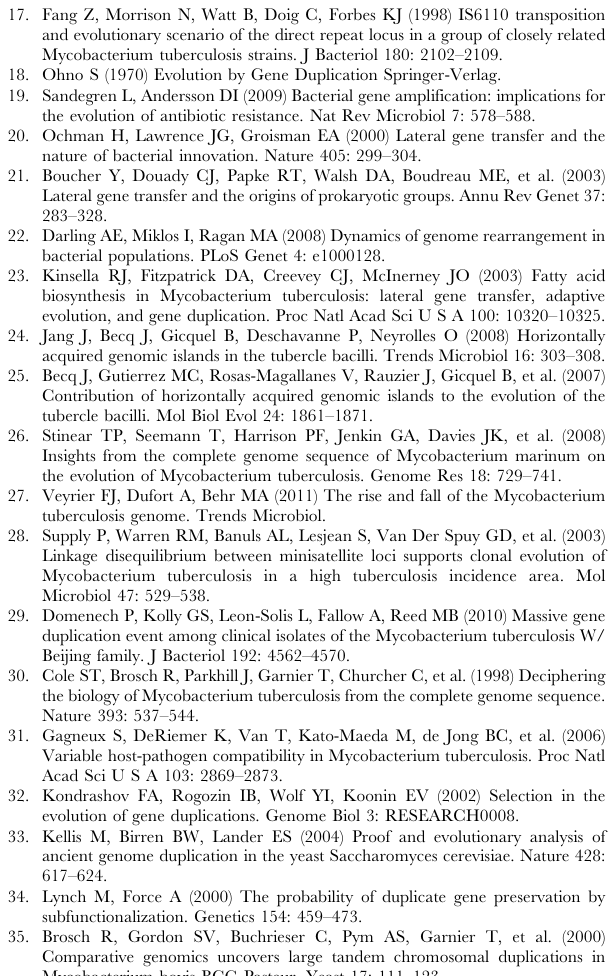
Figure S3 Coverage plot showing RD207: 3,120,521 to